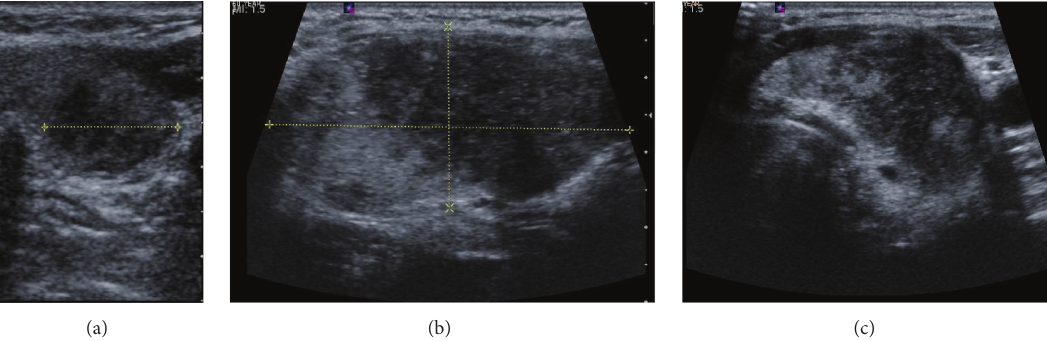
Figure 1: Thyroid ultrasound: (a) left midlobe dominant nodule in transverse view 1.4 × 1.3 × 1.5cm (total lobe volume 8 mL) before FNA; (b) left lobe nodule in sagittal view 3.9 × 2.3 × 2.2 cm (total lobe volume 15.5 mL) after FNA; (c) left thyroid lobe 1 month after second FNA (total lobe volume 6.5 mL).